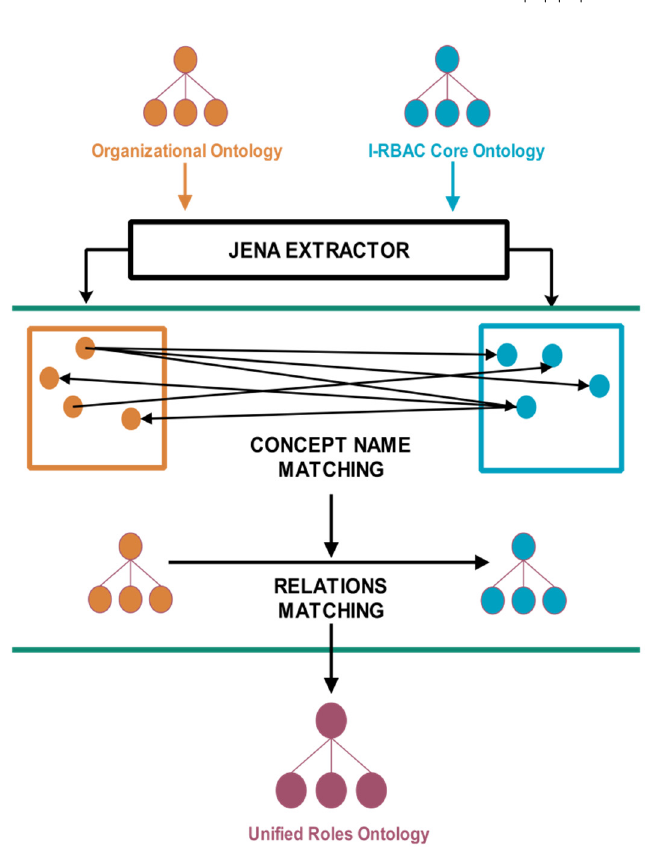
Figure 6. Ontology matching paradigm.